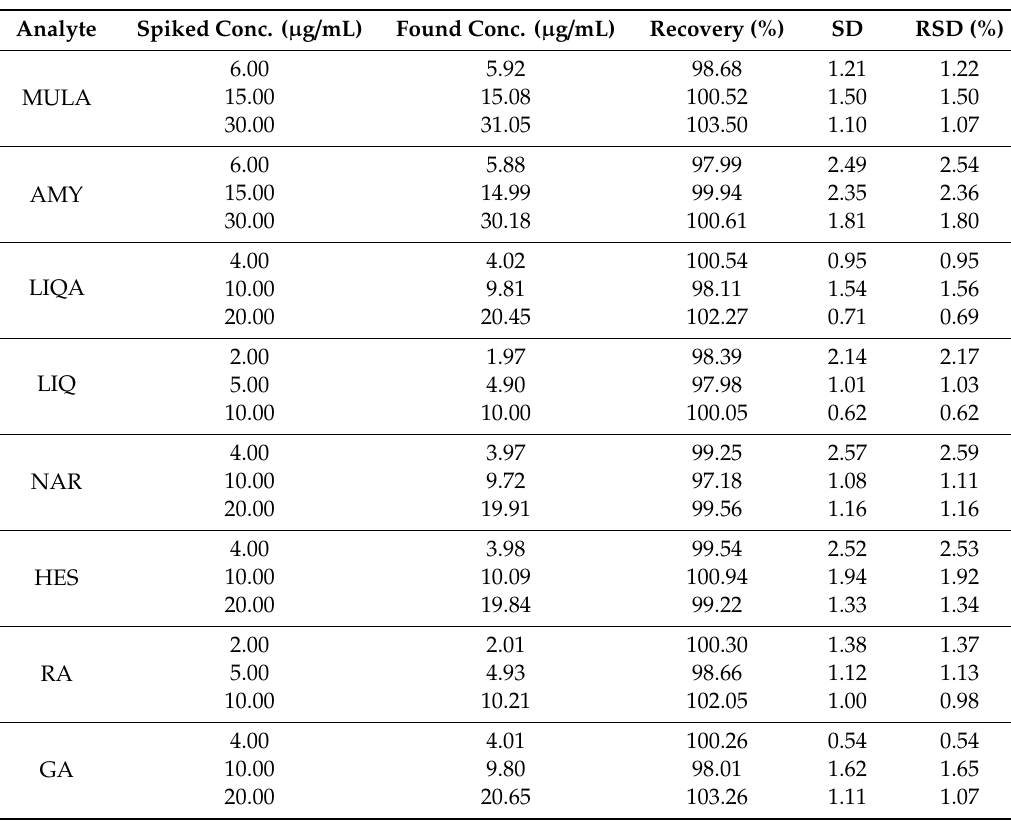
Table 2. Recovery test for the assay of the eight marker components in HPYJT (Haepyoyijin-tang). Analyte Spiked Conc. ( µ g / mL) Found Conc. ( µ g /